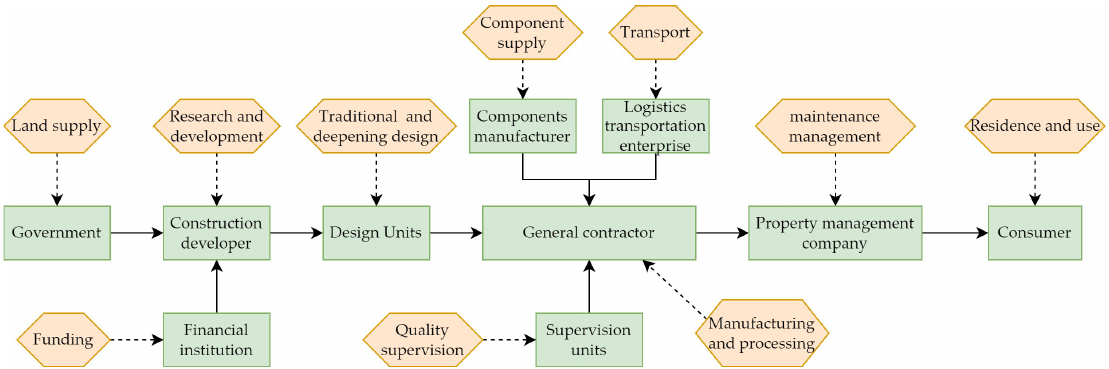
Figure 1. Prefabricated buildings supply chain. Note: Green represents supply chain participants and yellow represents building life cycle activities.